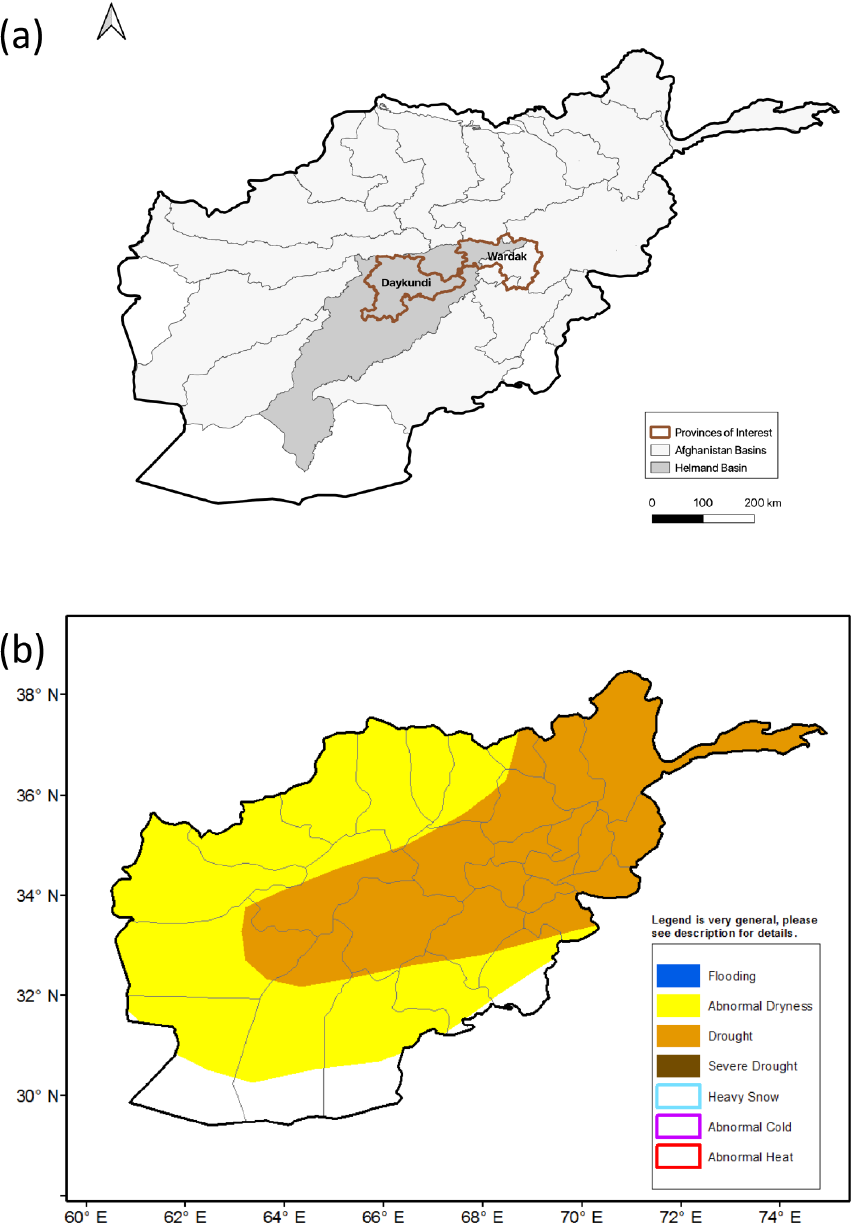
Figure 8. (a) Map showing hydrological basins, with Helmand Basin in darker gray and location of Daykundi and Wardak provinces (outlined in red) where food security conditions were of particular concern. (b) NOAA CPC Afghanistan hazard report for 22–28 February 2018 (CPC NOAA, 2018) showing widespread abnormal dryness and drought, defined by 90d precipitation deficits and extremely low snow water